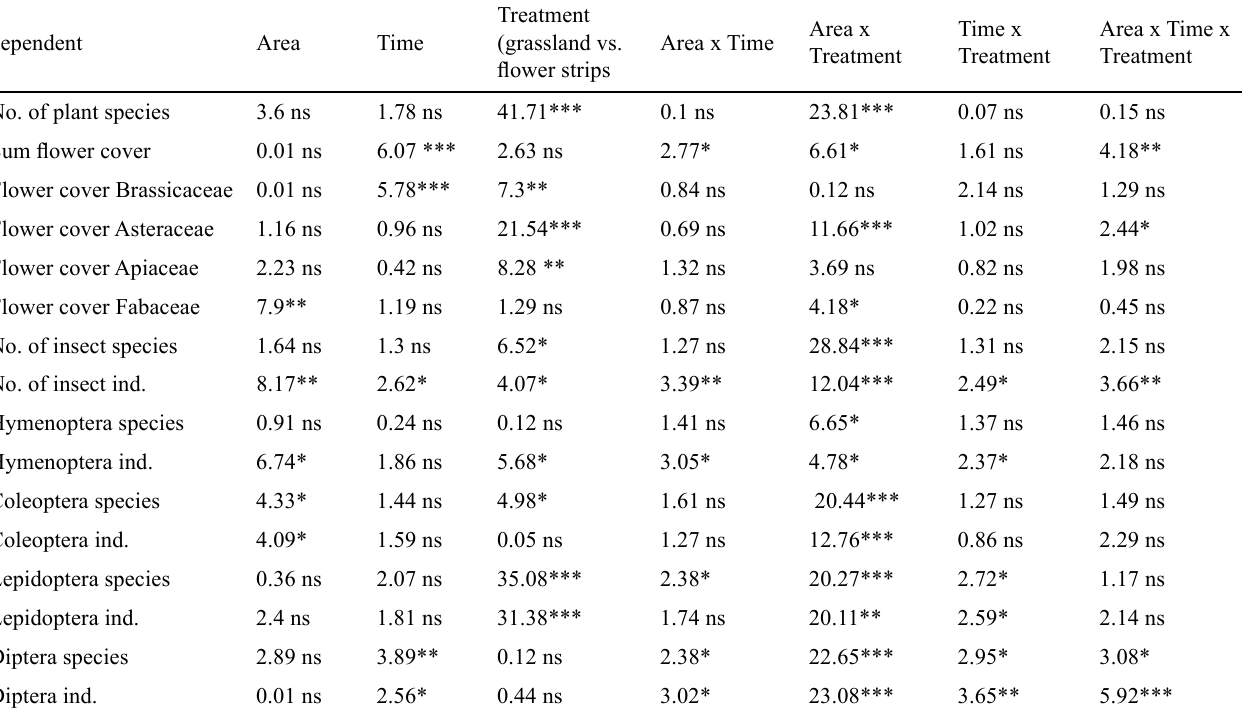
Table 2 . Differences of plant species diversity, flower cover, flower visiting insects and insect groups between the investigated locations (Bisamberg, Leopoldsberg/Nussberg) and habitats (flower strip and grassland) as well as their interactions. Three-way full factorial ANOVA. Values of Fisher-distribution (F-value) are shown. Significant effects are highlighted and marked as follows: * p<0.05, ** p<0.01 and *** p< 0.001. ns – not